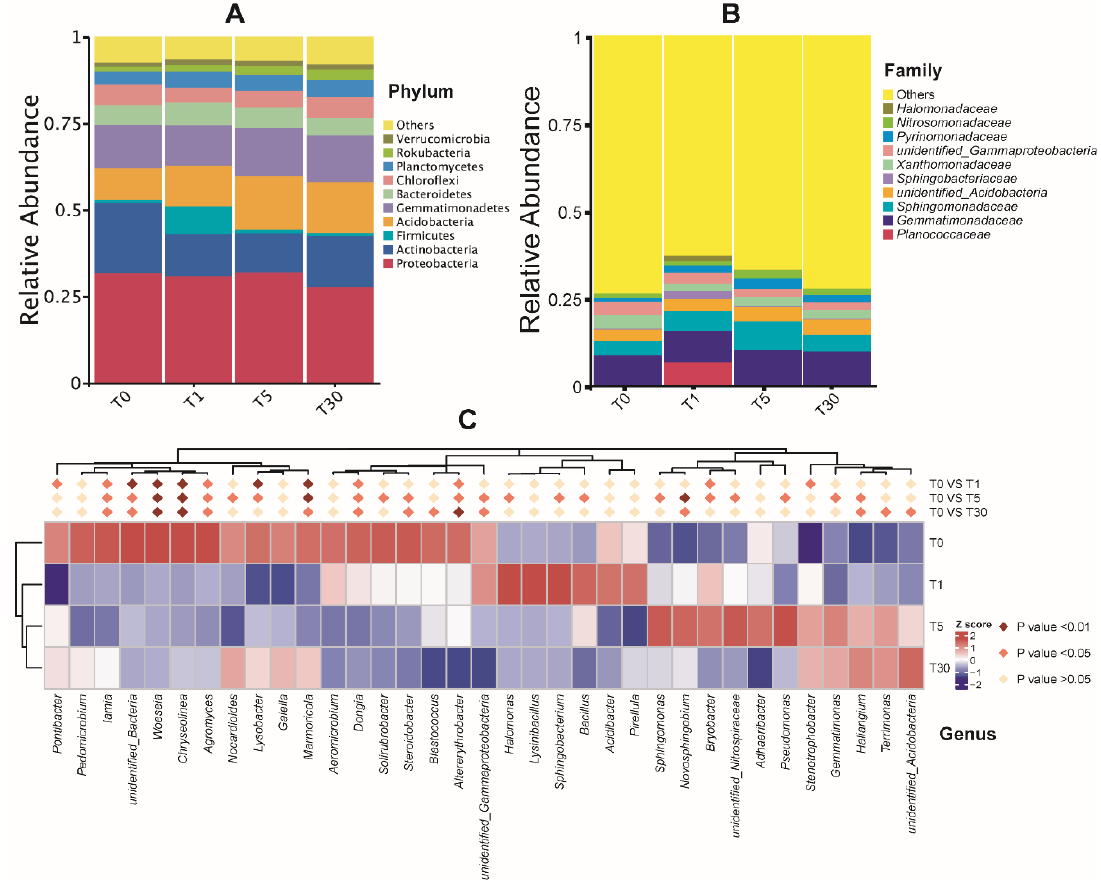
Figure 3. Taxonomic di ff erences of the bacterial community among four groups of samples. ( A ) The top 10 phyla; ( B ) the top 10 families; ( C ) relative abundances of the top 20 genera were compared to T0 using MetaStat